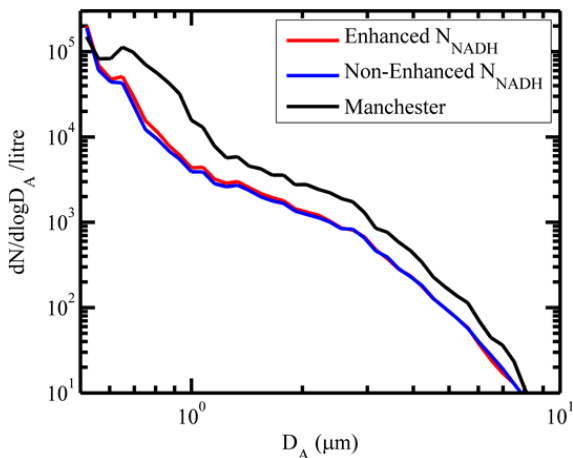
Fig. 4. Median APS aerosol number size distributions during N NADH enhancements and the intervening times compared with typical urban results from